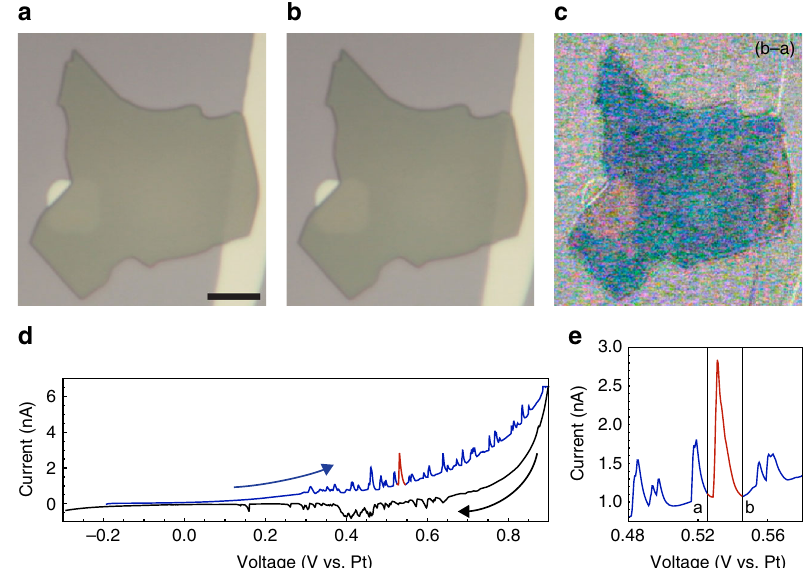
Fig. 3 Optical microscopy of intercalation event. a , b Two sequential photographs of a single crystal graphite fl ake as it undergoes an intercalation event. c Computed difference image (b – a) showing the graphite fl ake ’ s color change. d Full cyclic voltammogram for the complete intercalation/deintercalation cycle. Highlighted in red is the current peak associated with the intercalation event, which contains 2.0 nC, equivalent to 4.3 intercalant layers. e Section of the full cycle in d emphasizing the current peak. The black bars indicate when photographs ( a , b ) were acquired. The scale bar is 10 μ